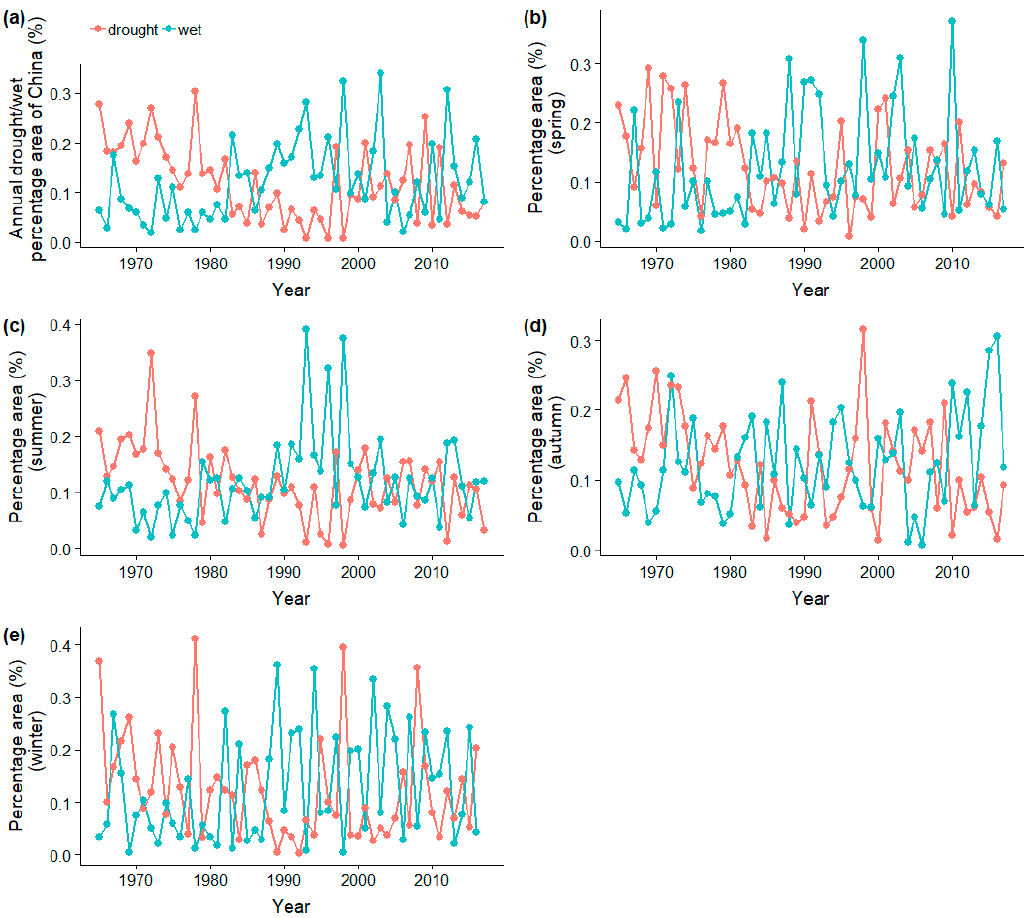
Figure 9. Temporal variations in the annual ( a ) and seasonal ( b – e ) percentage of areas in drought (standardized precipitation evapotranspiration index (SPEI) < − 1) and wet (SPEI > 1) conditions over the whole of China.